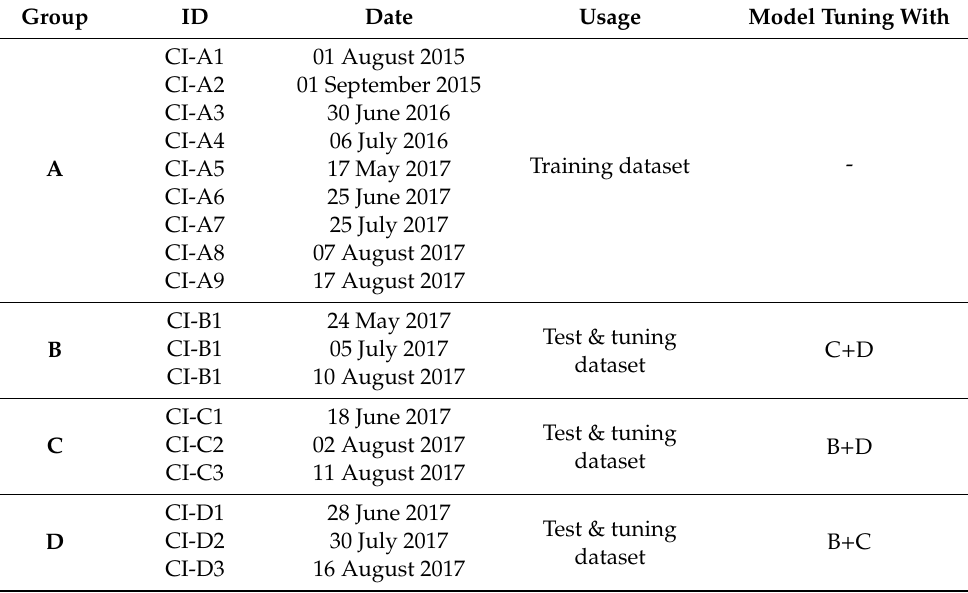
Table 3. The list of CI cases used in this